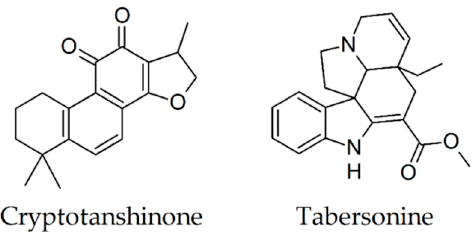
Figure 8. Chemical structures of cryptotanshinone and tabersonine.